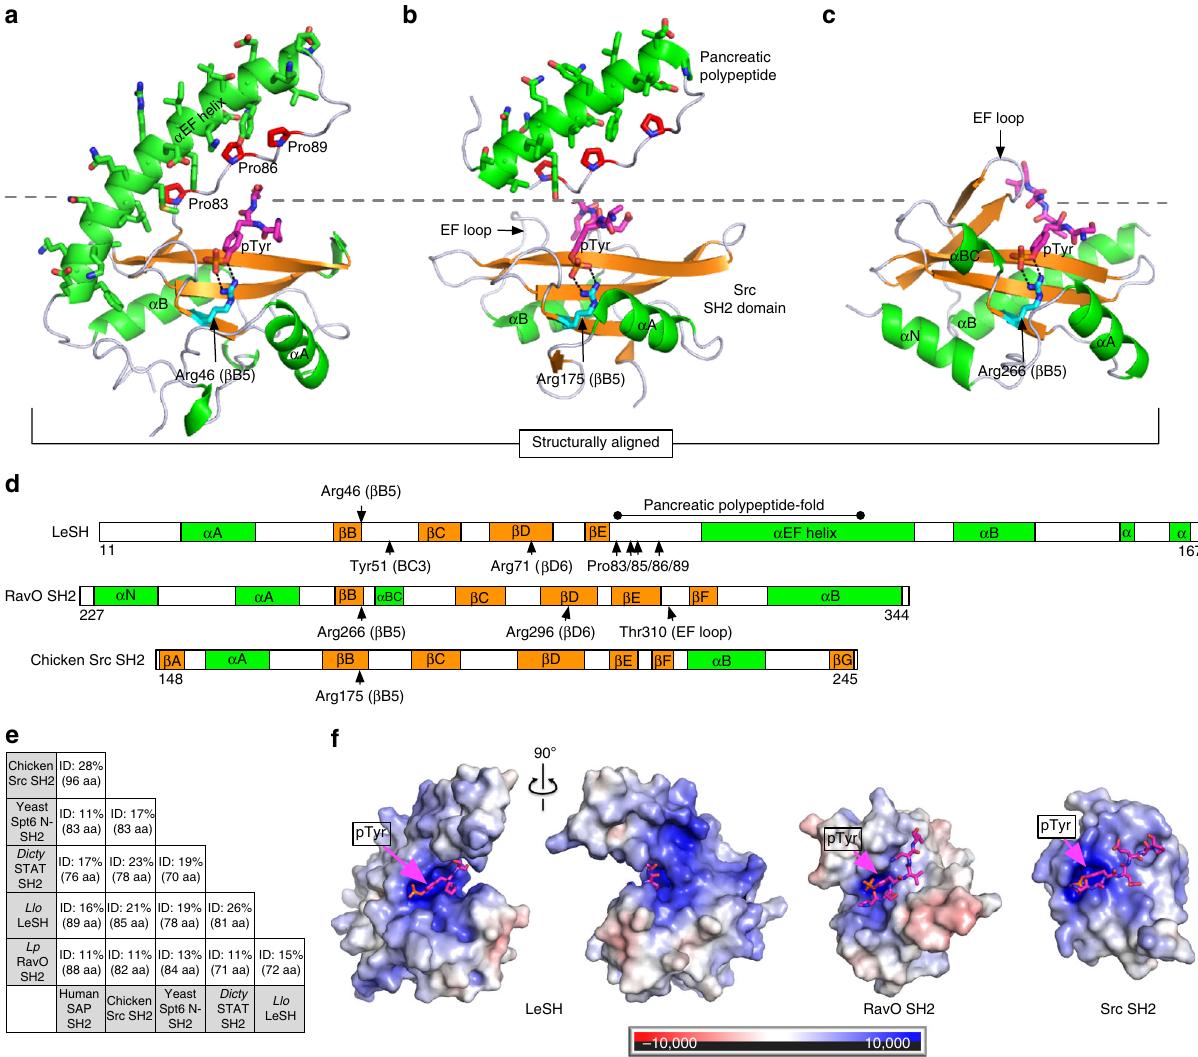
Fig. 4 Structures of two Legionella SH2 domains with bound phosphopeptides. a Crystal structure of L. longbeachae LeSH in complex with the IL2R β pTyr387 peptide. Only three residues (Pro-pTyr-Ser) could be traced in the electron density (see Supplementary Fig. 8d). The three prolines associating with the hydrophobic side of the protruding α EF helix are shown in sticks and colored red. See Supplementary Fig. 8e for amphipathic nature of the helical extension. b The Src SH2 domain with the avian pancreatic polypeptide shown on top to mimic the LeSH structure. Pro residues in the pancreatic polypeptide that make contact with the hydrophobic side of the α -helix ( α EF) are colored red. c Crystal structure of the RavO SH2 domain in complex with the Shc1 pTyr317 peptide. Panels a and c are structurally aligned to the Src SH2 domain. Helices and β strands in the SH2 domains are shown in green and orange ribbons, respectively. The conserved β B5 arginine is colored cyan. The bound phosphopeptides are in magenta sticks. d A comparison of secondary structures for the three SH2 domains. e Sequence identity between Legionella and selected eukaryotic SH2 domains based on structure-based alignments. SH2 domains from the chicken Src, human SAP, Dictyostelium STAT, and yeast Spt6 protein were included for the structure-guided sequence identity calculation. The total number of aligned residues in each pairwise structural comparison was given in the parenthesis. f Electrostatic surface potential of the LeSH, RavO, and Src SH2 domains drawn with the same scale. The bound peptides are shown as magenta sticks. The surface is colored in a gradient from red (negative) to blue (positive electronic